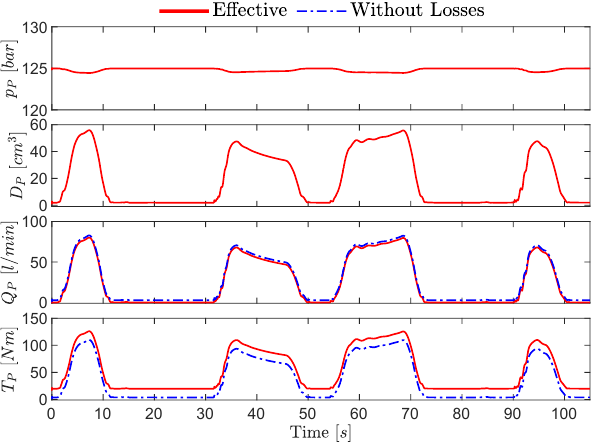
Figure 22: Hydraulic power unit